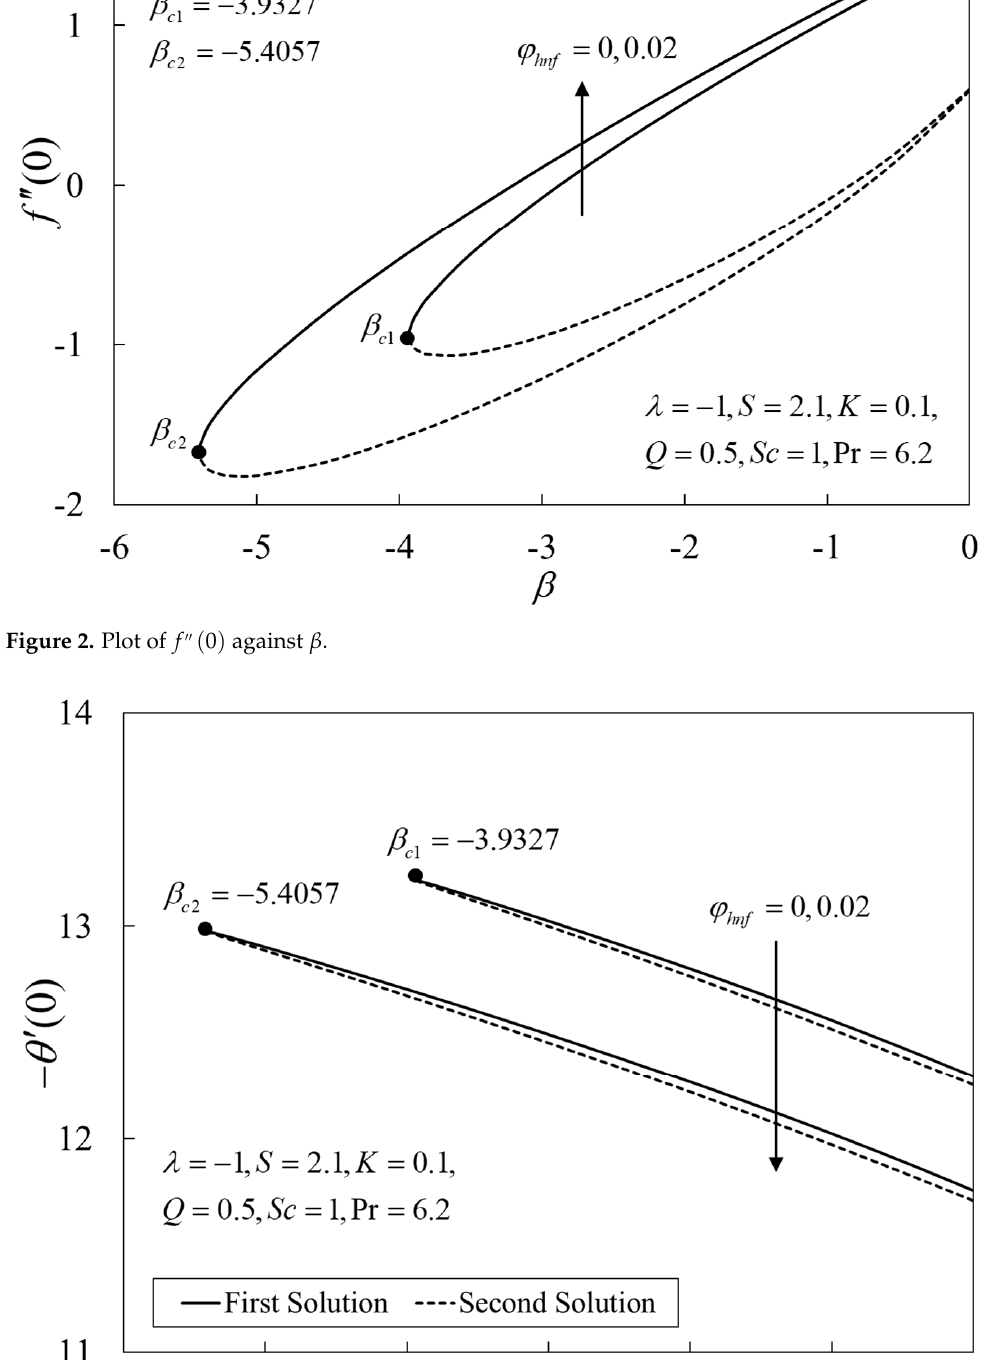
Figure 4. Plot of (0)  against  .